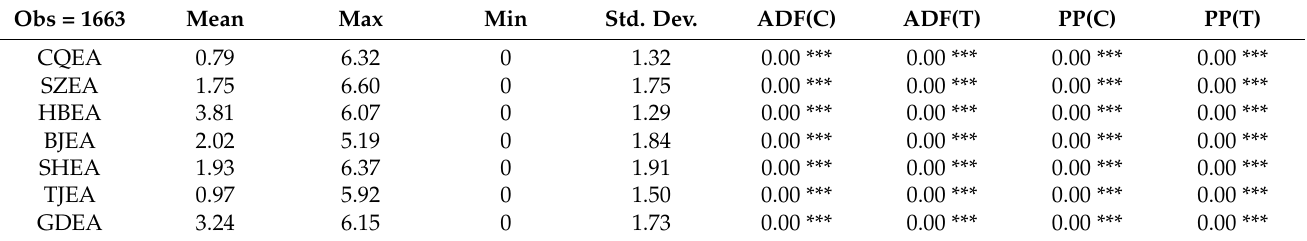
Table 1. Descriptive statistics and previous test of the demand in seven